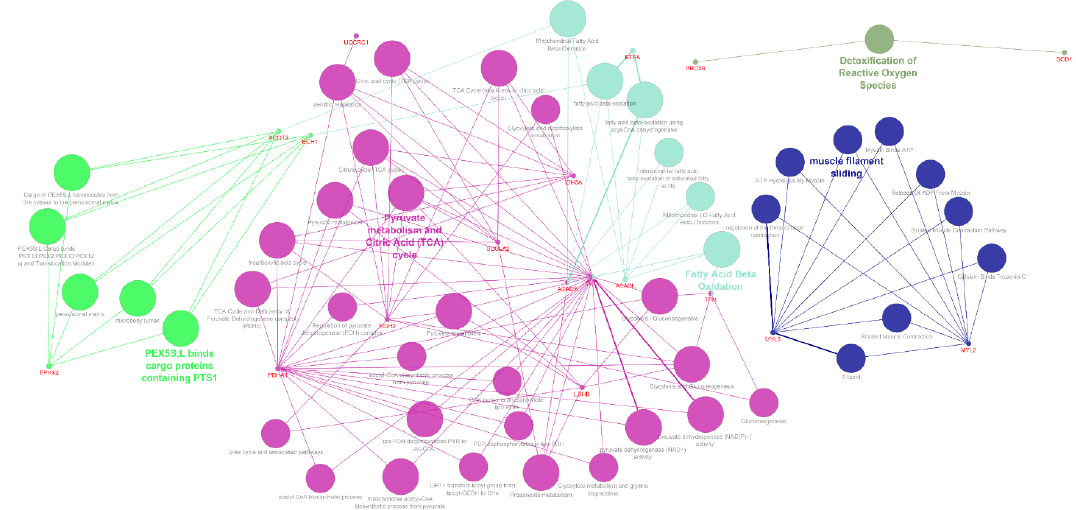
Figure 4. The ClueGO gene network of significantly altered pathways in cardiac muscle after 3 months of high-fat diets ingestion. Each node represents the Gene Ontology (GO) biological process/pathways and colors represent the GO group.